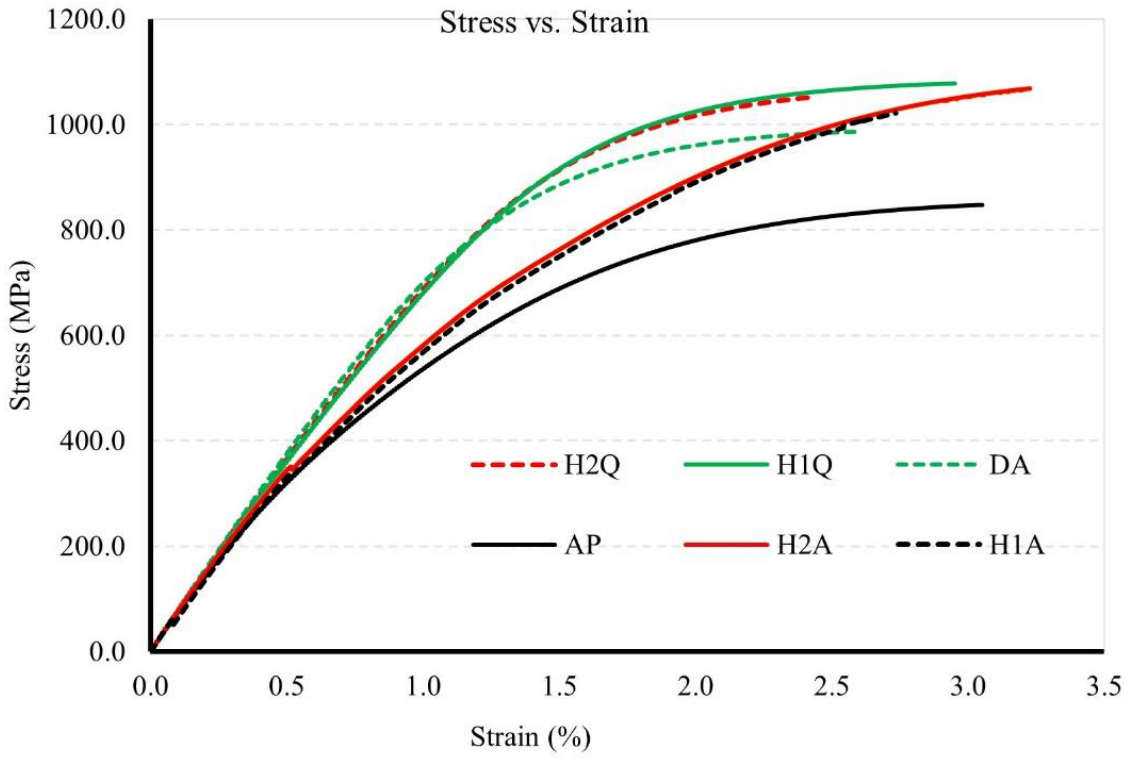
Figure 13. Engineering stress–strain curves of the as-printed and heat-treated samples. 429